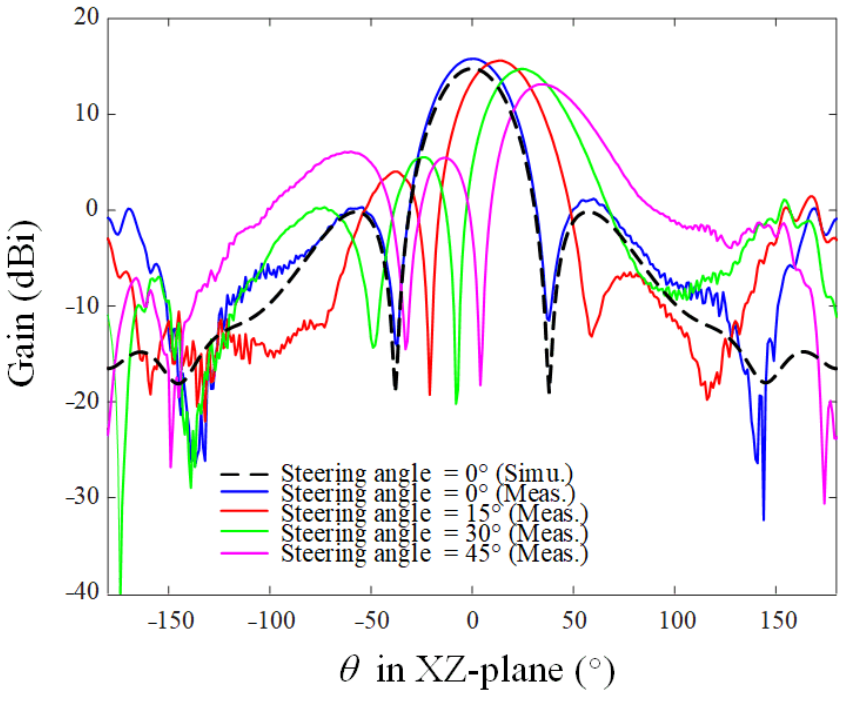
Figure 7. Simulated and measured steering array beam patterns at 9.5